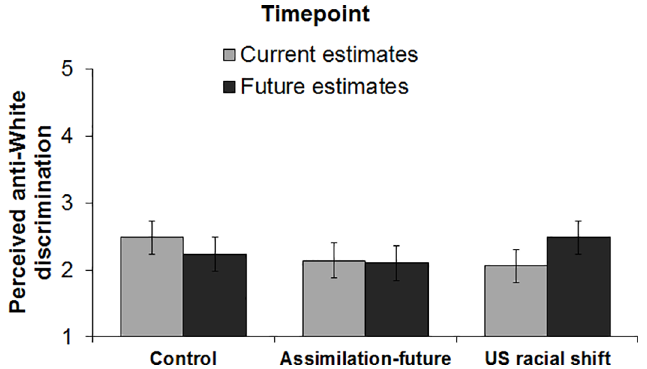
Fig 3. Perceived anti-White discrimination by experimental condition and timepoint (Study 4). Error bars represent within-subjects 95% confidenceintervals[27].